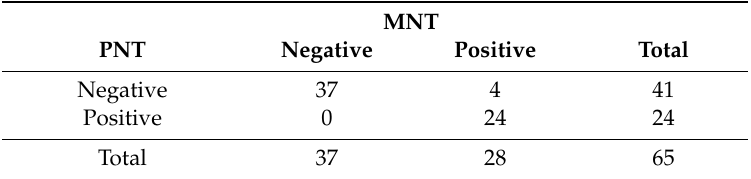
only titres obtained for 4 sera were found to be discordant. Table 1. Error matrix. Reliability of PNT compared to MNT in serum samples from 65 subjects. Titres greater than log2(5) were labelled as “Positive,” and otherwise as “Negative.” With MNT taken as the reference (true) results, the table shows the misclassifications.